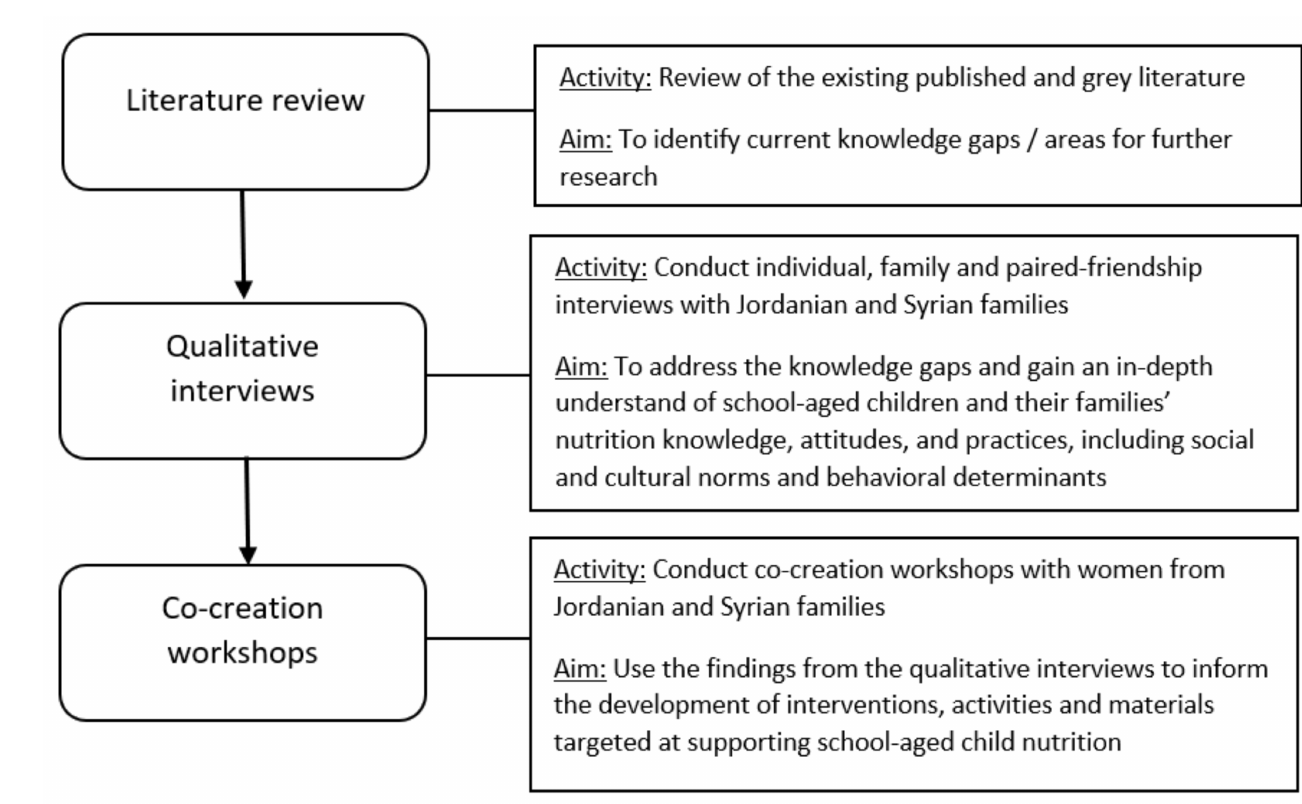
Figure 1. Process used.